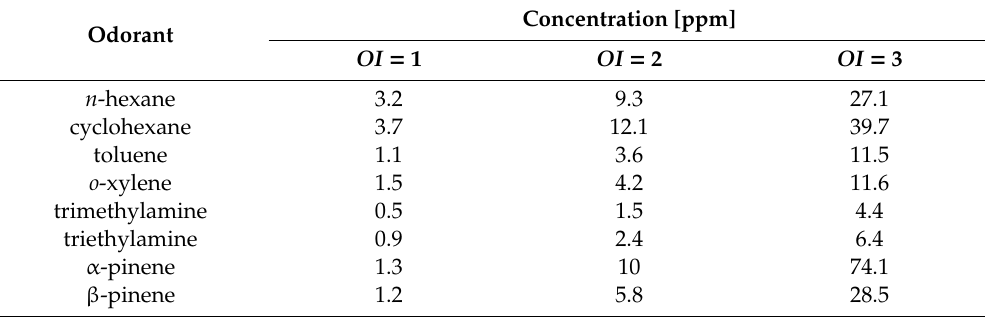
Table 5. Concentration of individual substances used for generation mixture characterized with specific odor intensity value.